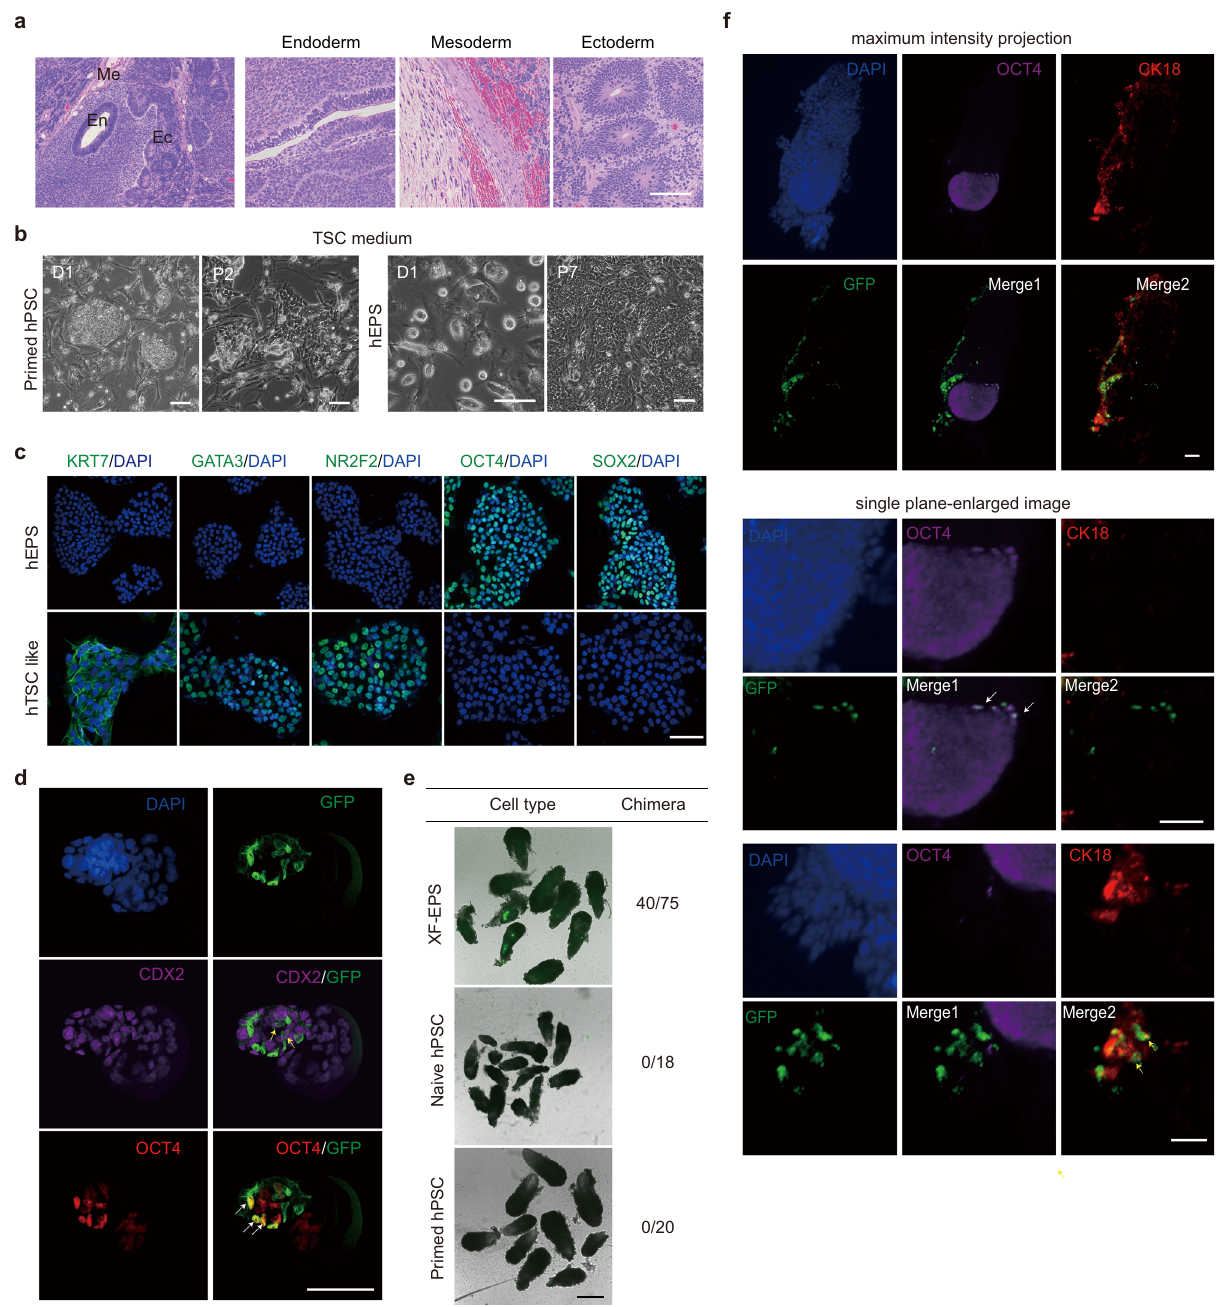
Fig. 4 Characterization of embryonic and extraembryonic developmental potentials of xeno-free hEPS cells in vitro and in vivo. a Representative images showing histological analysis of teratomas generated from xeno-free hEPS cells. Scale bars, 100 µ m. Similar images were obtained in at least 3 independent experiments. b Phase contrast images of primed and XF-EPS cells. To derive hTSC-like cells, primed hPSCs and XF-EPS cells were cultured in hTSC medium. Primed H1 and XF H1-EPS cells were used. Scale bars, 100 µ m. Similar images were obtained in at least three independent experiments. c Representative immune-staining images showing the marker expression of XF-EPS cells and hTSC-like cells. XF H1-EPS cells were used. Scale bars, 100 µ m. Similar images were obtained in at least three independent experiments. d Representative images showing chimerism of xeno-free hEPS cells in E4.5 mouse blastocysts. GFP, anti-GFP antibody. White and yellow arrows indicate GFP + cells with OCT4 and CDX2 expression respectively. Scale bar, 100 µ m. Similar images were obtained in at least 5 independent experiments. e Chimerism of XF-EPS cells, naive hPSCs and primed hPSCs in E6.5 mouse conceptuses. Representative images of chimerism were shown. A summary of the chimeric experiment was also shown. Scale bar, 500 µ m. f Immuno fl uorescent staining of E6.5 chimeric embryos showing lineage contributions of xeno-free hEPS derivatives to epiblast or trophoblast lineages. mclover + ES1-EPS cells were used. Embryos were stained for OCT4 (epiblast), CK18 (trophoblast compartment) and mclover (GFP). White and yellow arrows indicate GFP + cells with OCT4 and CK18 expression respectively. Scale bars, 50 µ m. Similar images were obtained in at least 5 independent experiments. Experiments in a – f were all independently repeated at least three times with similar